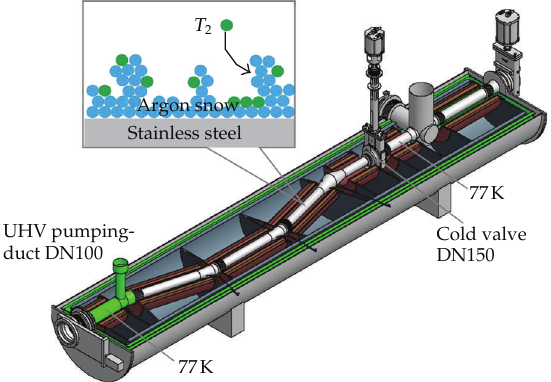
Figure 18: Schematic view of the seven beam tube elements of the CPS. The inner surface of the cryopump elements is covered with argon snow to capture the remaining tritium